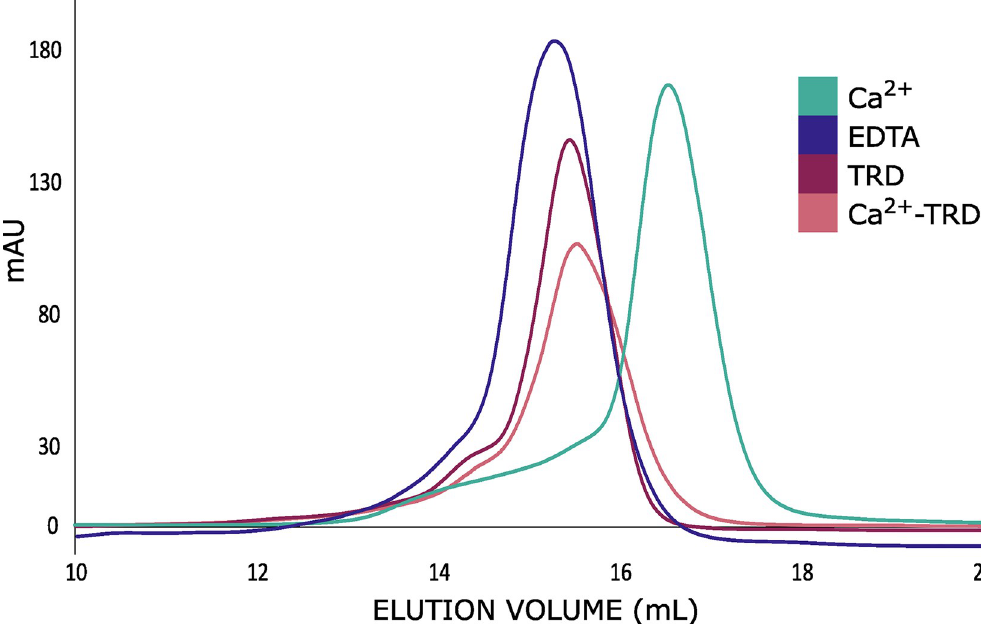
Fig 5. Annexin-host interaction. Shift in elution from a Superose 6 Increase 10/30 analytical column for recombinant annexin in response to 1 mM CaCl 2 or 1 mM EDTA. In the presence of host root diffusates (TRD), annexin no longer shifts to the calcium bound